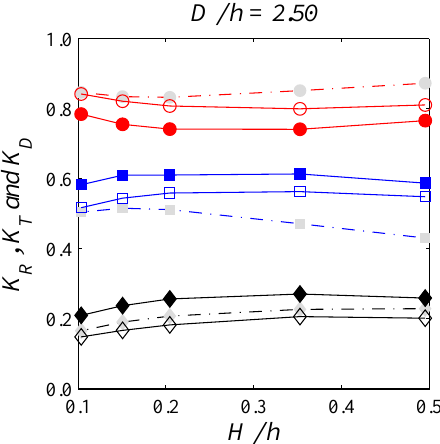
Figure 10. Effects of H / h on the hydraulic performance for fixed D / h = 2.50. The hollow and solid symbols respectively depict the results of N 1 = N 2 = 0.10 and 0.00 scenarios. The dashed lines with gray signs show the results of single solid barrier case. Black, red and blue colors represent K R , K T and K D , respectively.